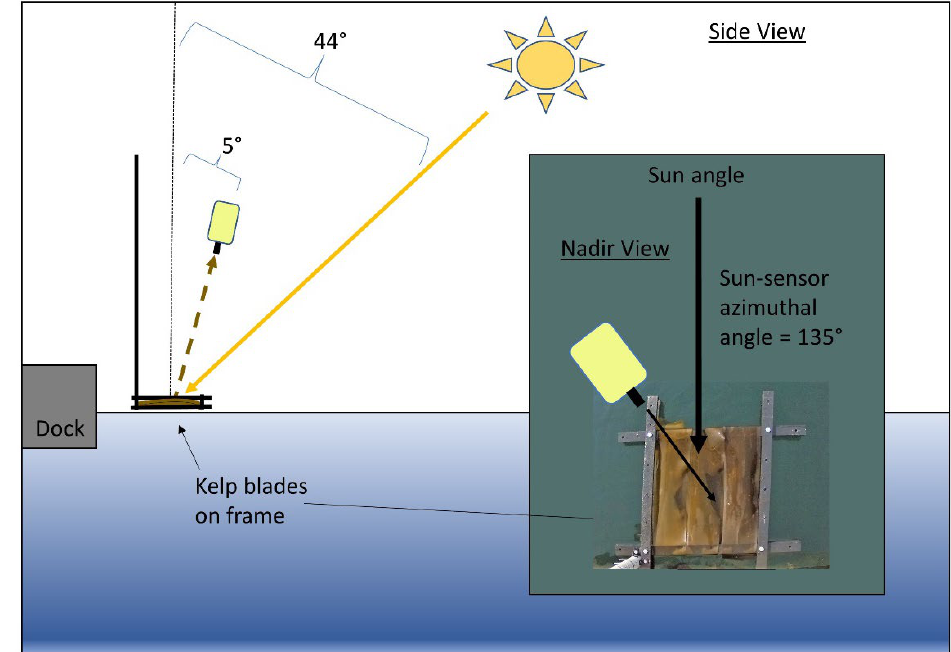
Figure 1. Side view of submergence experiment showing the geometry of acquisition for spectrora- diometer and angle of zenith for the sun. Inset shows nadir view of the experiment with the azimuthal angle between spectroradiometer and sun and kelp blades inside the black frame. Diagrams are not to scale. Table 1. Spectral parameters used to calculate above-water reflectance, as per Equation (1). All spec- tral measurements were collected using a calibrated ASD Fieldspec Handheld2 spectroradiometer with a one-degree fore optic (full viewing-angle), which detects a wavelength range from 325–1075 nm at 1 nm increments.